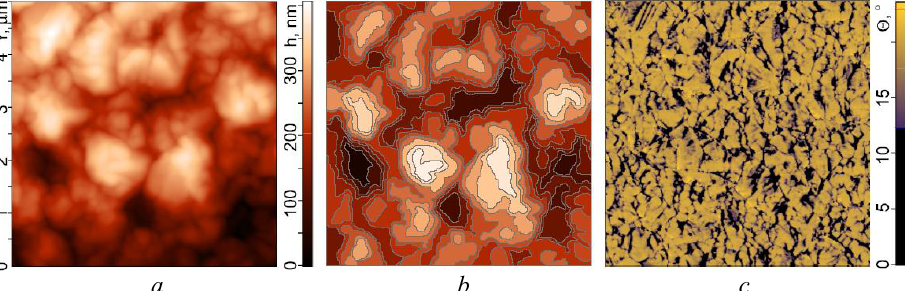
Fig. 2 . The AFM images of surface relief — a ), its contour image — b ) and phase contrast — c